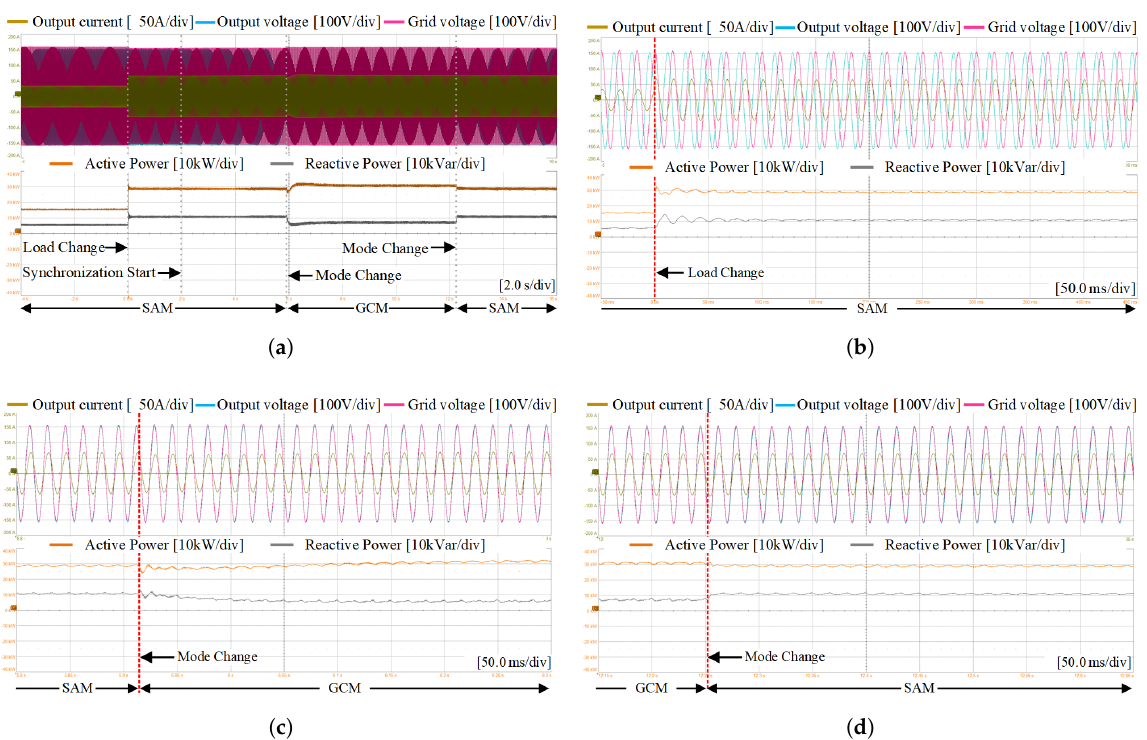
Figure 13. HILS based experimental results of proposed control method with parallel R-L load condition ( a ) overall sequence, ( b ) load step change, ( c ) SAM to GCM transition, ( d ) GCM to SAM